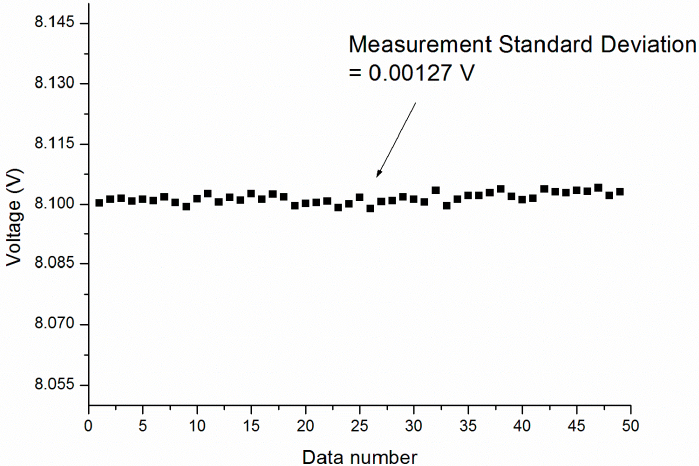
Figure A1. Sensor measurement stability in water sensing (1.3330 RIU). Measurement standard deviation (S.D.) was found to be 0.00127 V within 50 averaged data points (each data point is averaged from 10 readings).